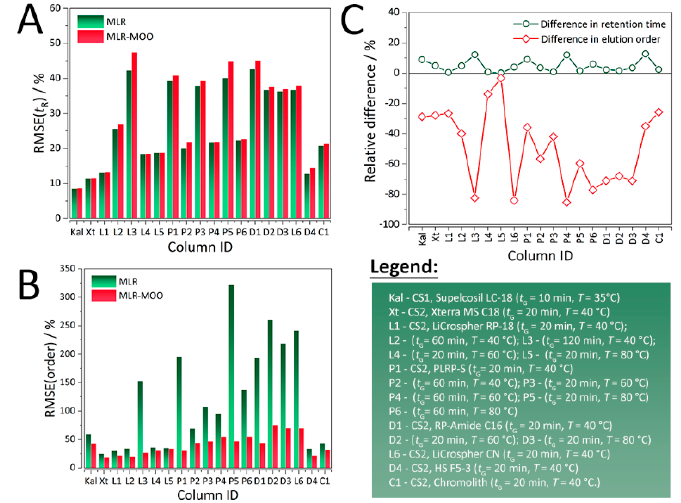
Figure 2. Distribution of %RMSE values of MLR (control) and MLR-MOO models for ( A ) retention time, ( B ) elution order, and ( C ) relative di ff erence in retention time and elution order RMSE values between MLR and MLR-MOO. In ( A , B ) the color bars are in sequence (first MLR, then MLR-MOO). In ( C ) the lines with open circle shapes represent the relative di ff erences in retention time, whereas the lines with open diamond shapes represent the di ff erences in elution order. All the abbreviations are explained in the